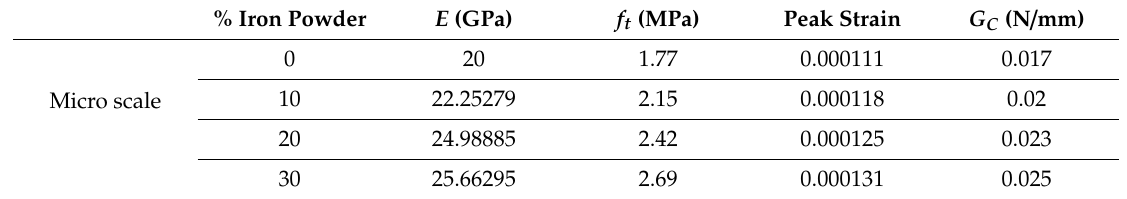
Table 1. Parameters and material properties for iron powder incorporated